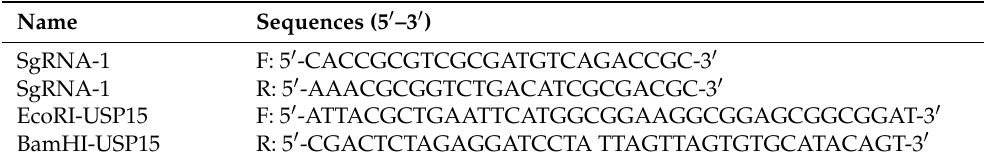
Table 2. Sequence of primers. F—forward;